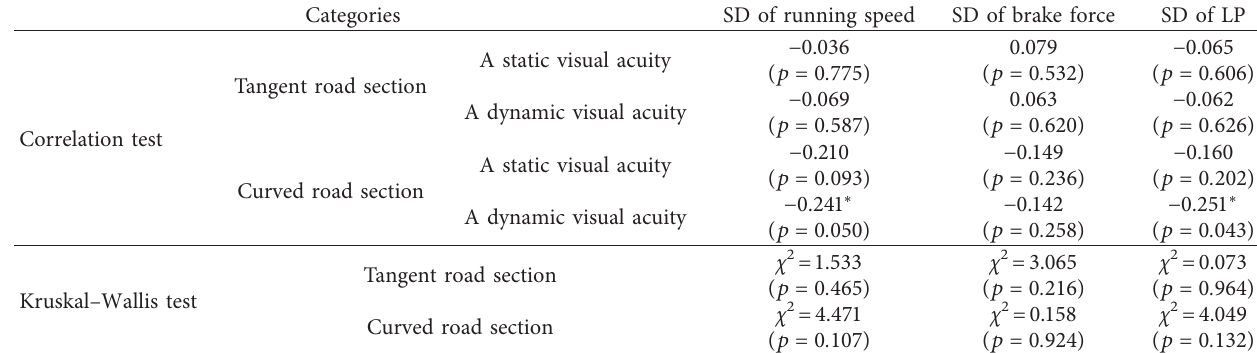
Table 4: Correlation analyses and Kruskal–Wallis tests in scenario 2